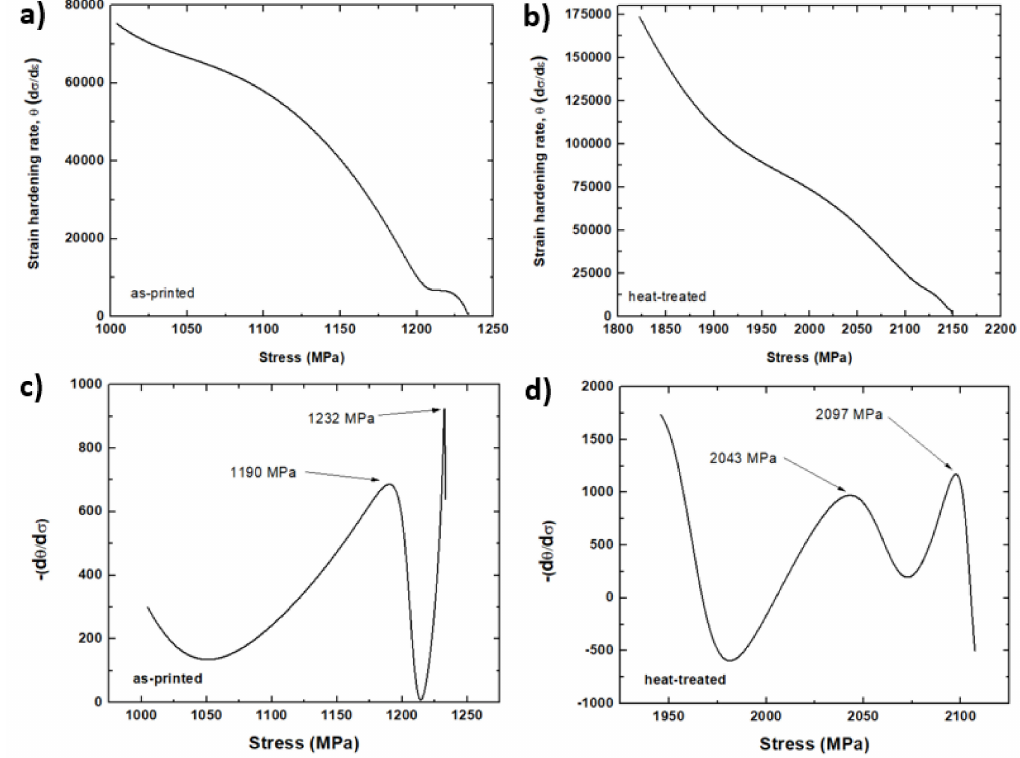
Figure 14. The dependence of strain hardening rate on applied stress for ( a ) as-printed and ( b ) heat-treated samples. The dependence of the derivative of strain hardening rate on the applied stress for ( c ) as-printed and ( d ) heat-treated